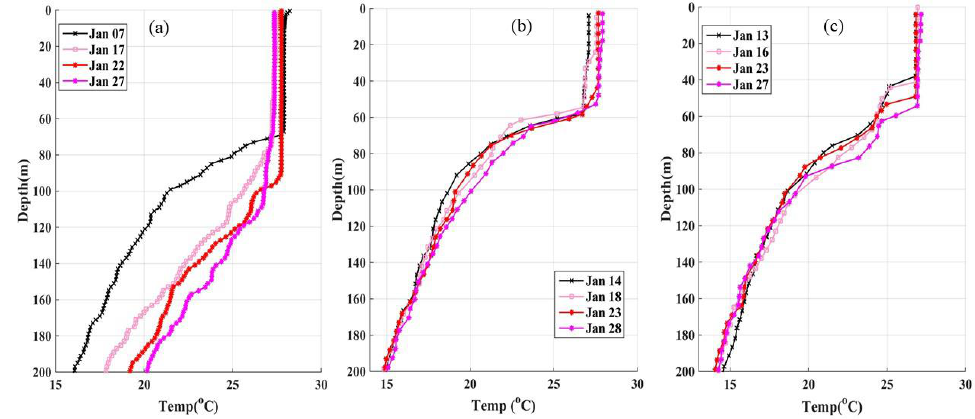
Figure 14. Vertical profiles of temperature at three Argo stations ( a ) 2902753, ( b ) 2902784, and ( c ) 2902786 around the time of the eruption of the Taal